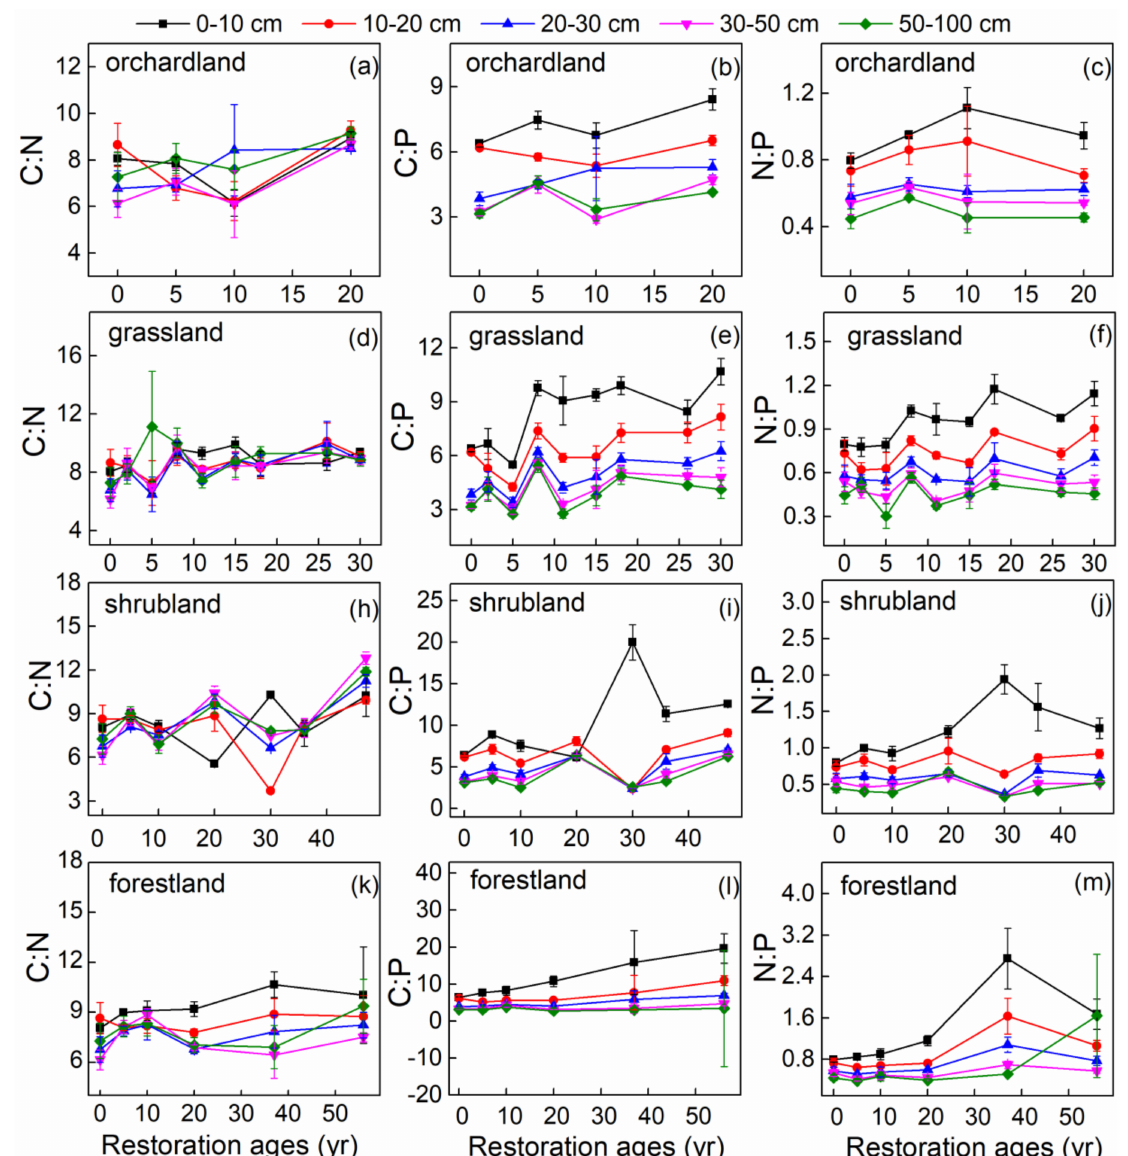
Figure 4. Stoichiometric characteristics of soil organic carbon (SOC), soil total nitrogen (TN), and soil total phosphorus (TP) with restoration age. Note: values are mean ± standard